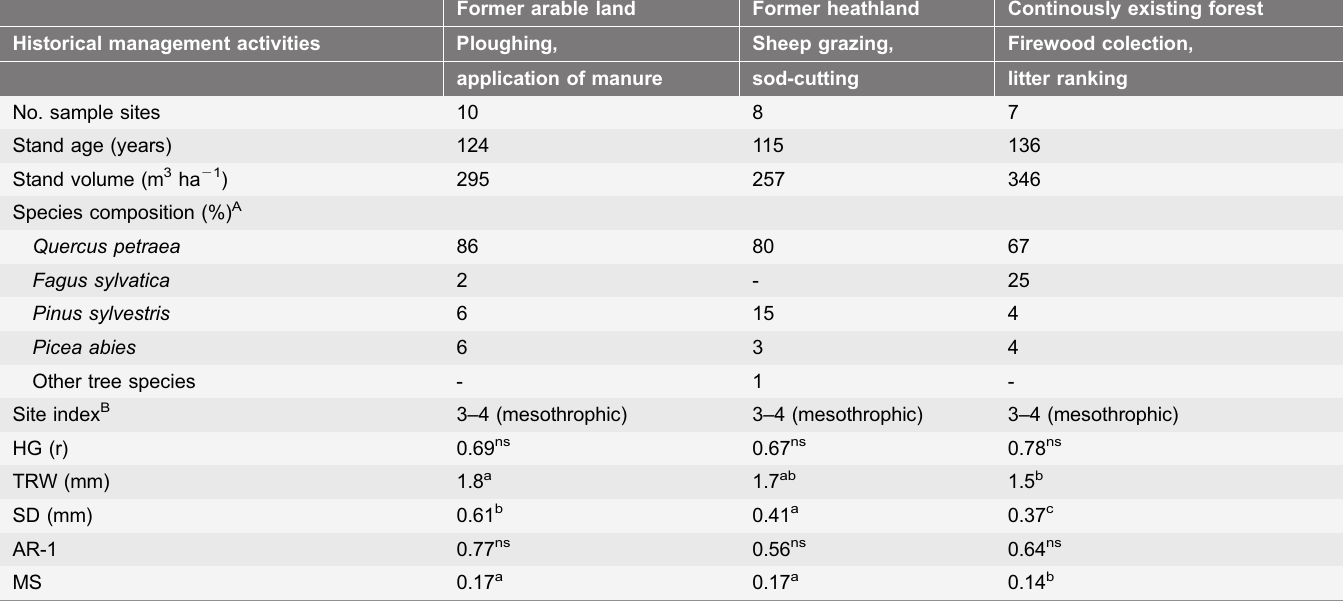
Table 1. Site land-use history and